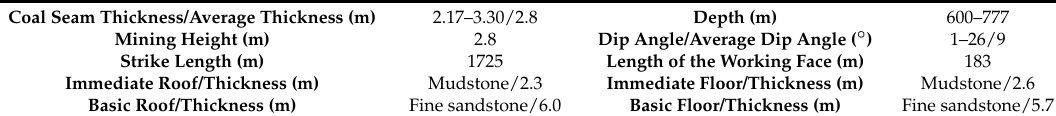
Table 4. Basic parameters of the II632 working face in the Hengyuan Coal Mine.